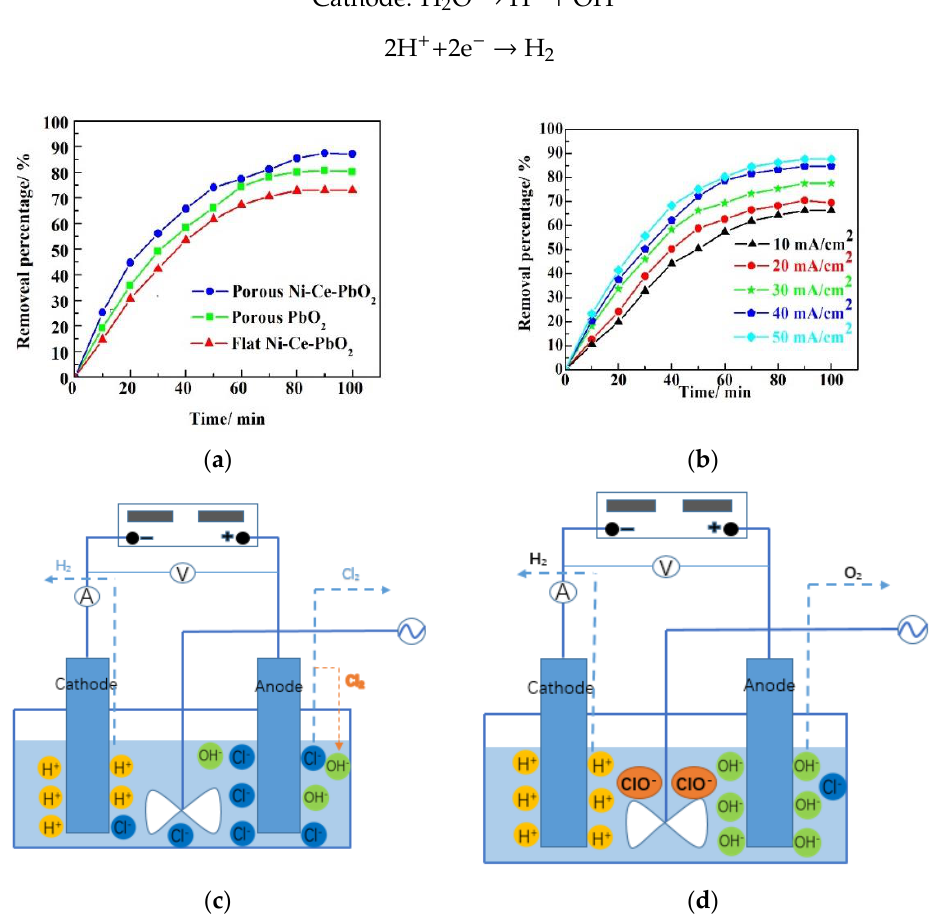
Figure 4. ( a ) Variation of Cl − removal percentage with time during electrochemical oxidation on different electrodes, conditions: current density = 50 mA/cm 2 ; T = 298 K; [Cl − ] = 4 g/L, ( b ) at different current densities, conditions: porous Ni-Ce-PbO 2 electrode; T = 298 K; [Cl − ] = 4 g/L and electrochemical reaction process of electrode dechlorinating ( c ) at 30 min and ( d ) at 100 min.